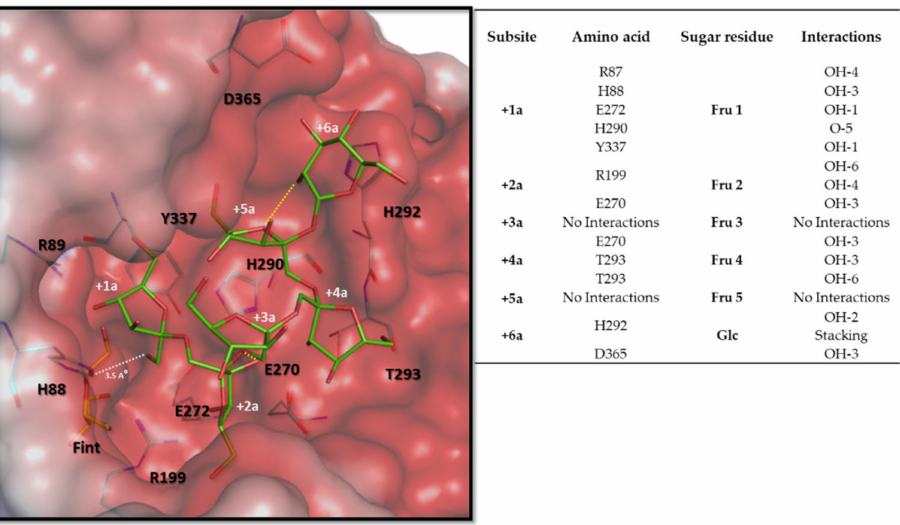
Figure 10. Conformation of the DP6 inulin acceptor binding mode obtained by docking analysis to the Hmc Isc inulosucrase fructosyl intermediate. The yellow dashed lines show intramolecular interactions of Fru3 and Fru5, not showing interactions with amino acids. The white dashed line shows the distance of the OH-1 of Fru1 and the anomeric carbon of the fructosyl intermediate (orange). The integrated table shows the amino acid interactions as detected by the molecular operating environment